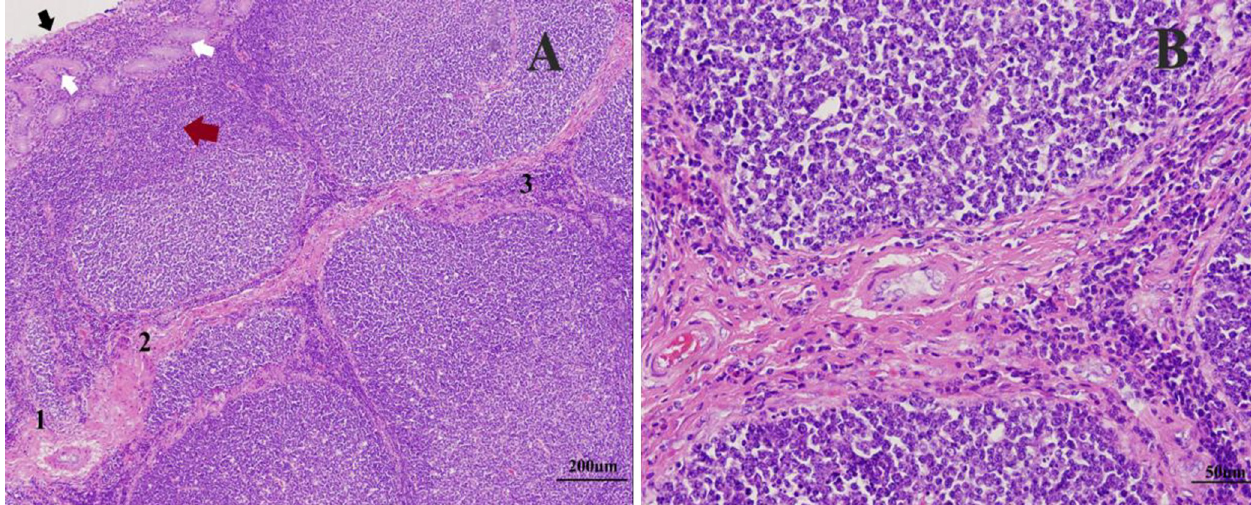
Fig 9. Part of mucosal fold stained with (H and E). (A): the epithelium (black arrows), mucous gland (white arrows), and solitary lymphoid tissue (red arrows) overlying the nodules with the interfollicular area containing HEV (1), connective tissue (2), and lymphoid cells (3). (B): high magnification of A thickening of the interfollicular area due to the infiltration of the connective tissue and lymphoid cells. (Original magnification: A = 100x, B = 400x).